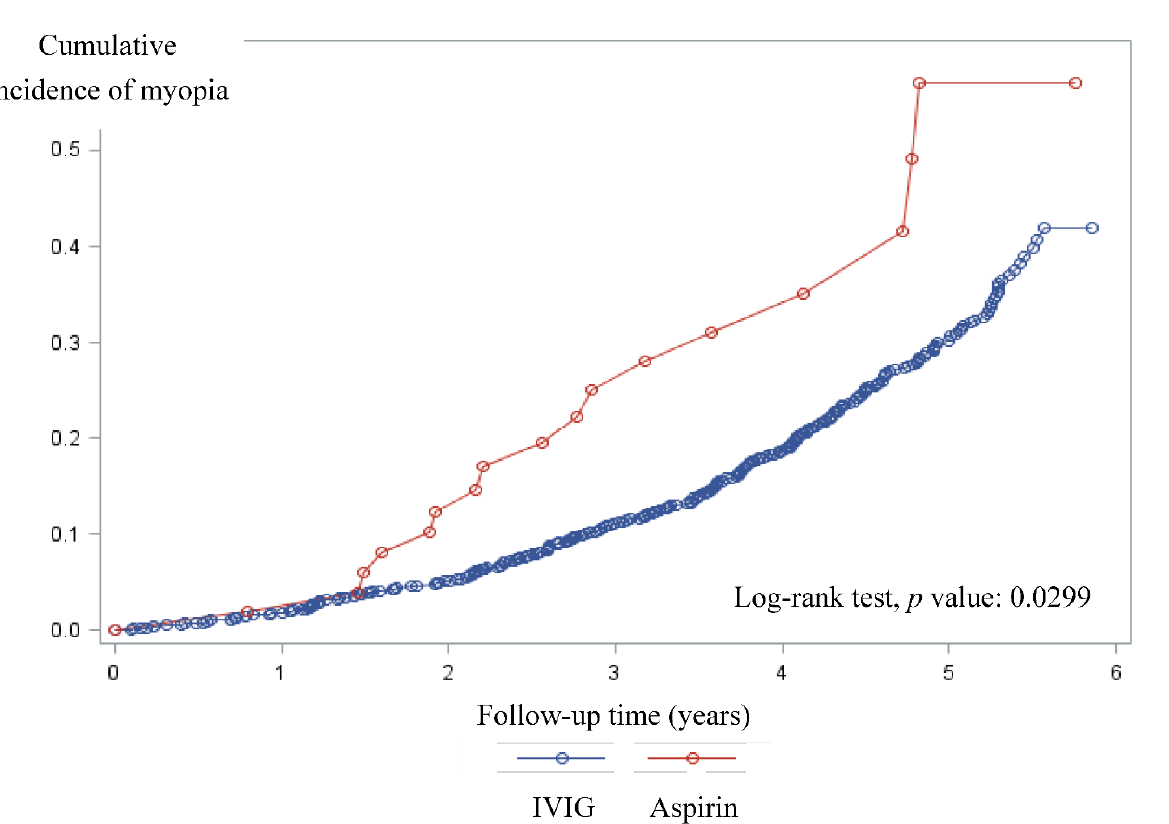
Table 1. Demographic data of Kawasaki disease patients.